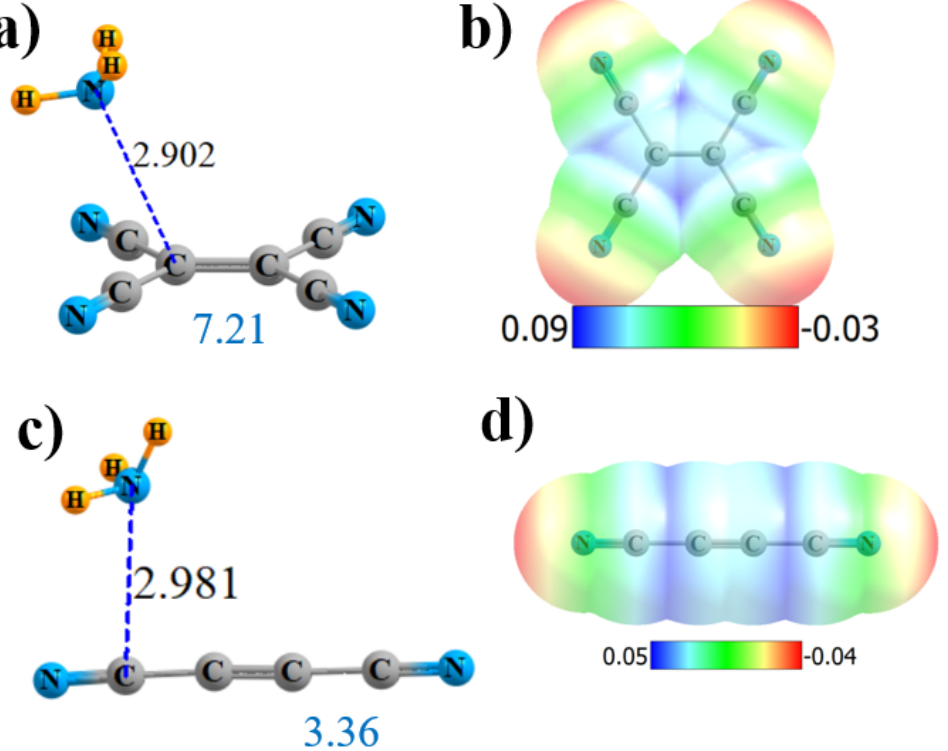
Figure 4. Geometries and monomer MEP of the complex of NH 3 with (CN) 2 C = C(CN) 2 ( a , b ) and (CN)C ≡ C(CN) ( c , d ).